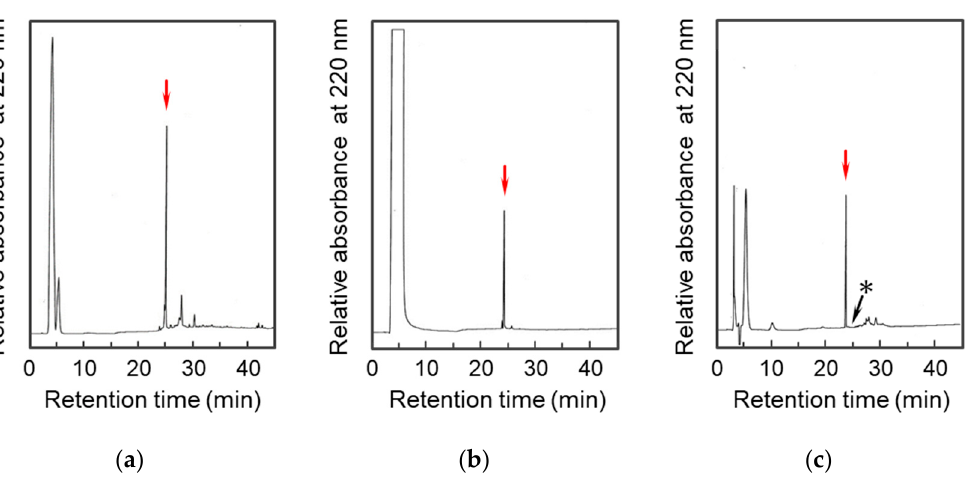
Figure 3. HPLC profiles of the preparation of the topological isomer and native form of [D-Cys 5 ,Asp 7 ,Val 8 ,D-Lys 16 ]-ST p (5-17) peptides. The air ( a ) and iodine ( b ) oxidations of the [D-Cys 5 ,Cys 6 (Acm),Asp 7 ,Val 8 ,Cys 14 (Acm),D-Lys 16 ]-ST p (5-17) with two disulfide bonds and the [D-Cys 5 ,Asp 7 ,Val 8 ,D-Lys 16 ]-ST p (5-17) peptide with three disulfide bonds, respectively. The thiol catalytic reaction ( c ) of the arrowed peak in ( b ). The target peptides are indicated by red arrows. The arrow with an asterisk indicates the position of the arrowed peak in ( b ). To obtain the native form of the [D-Cys 5 ,Asp 7 ,Val 8 ,D-Lys 16 ]-ST p (5-17) peptide, the ST p topological isomer was treated with 2-mercaptoethanol as a catalyst for isomerization. Only one peptide, which was assigned to the native form of the ST p peptide as